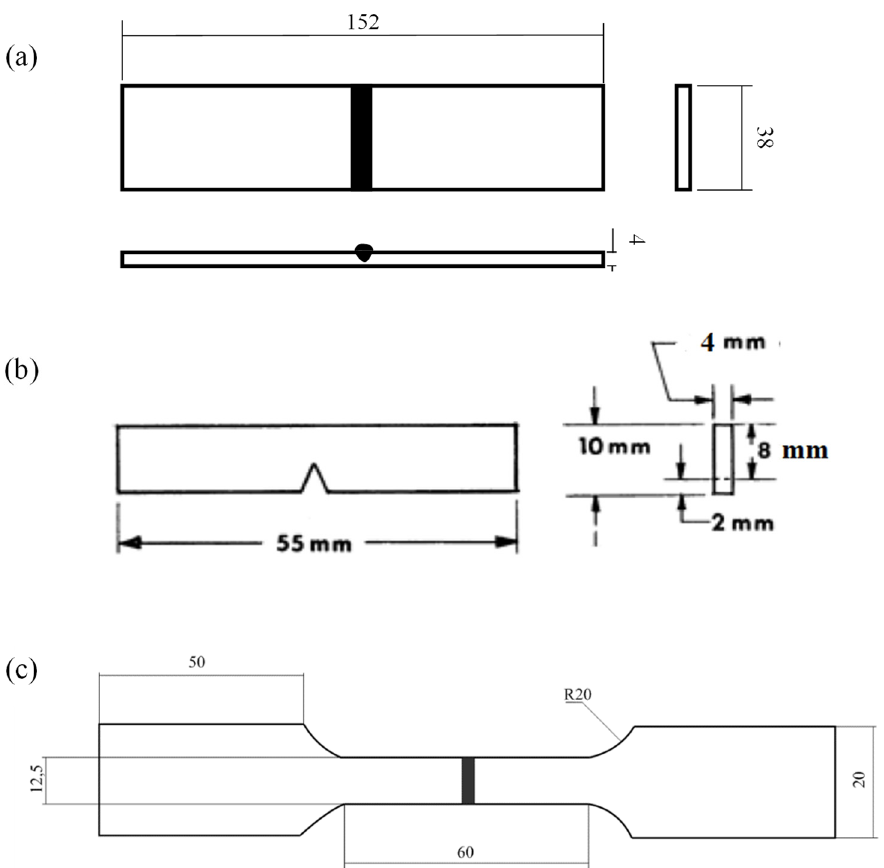
Figure 3. Sample specimens of ( a ) the bending test, ( b ) the impact test, and ( c ) the tensile test in (mm).